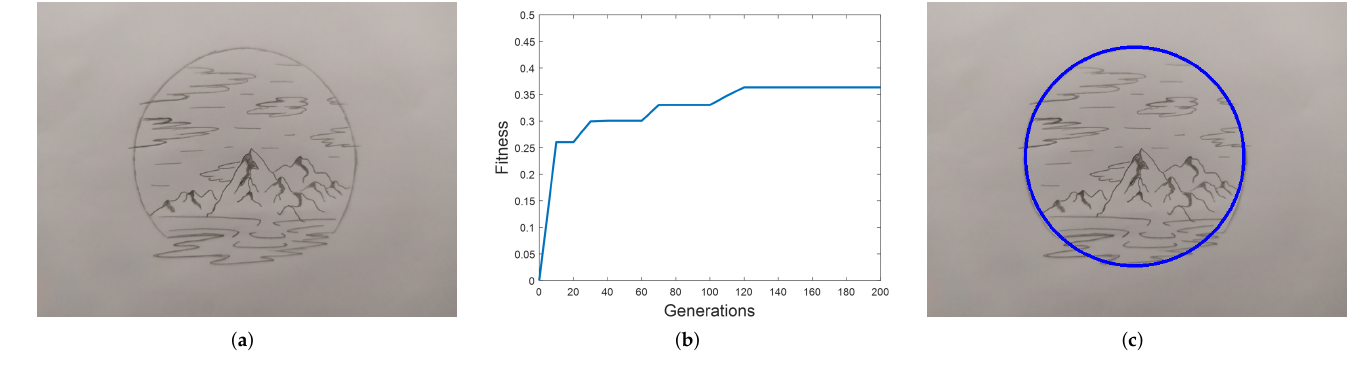
Figure 11. Hand-drawn input image ( a ), fitness evolution trend of the elite individual after one run of the detection system ( b ), and output image with the detected circle superimposed ( c ).